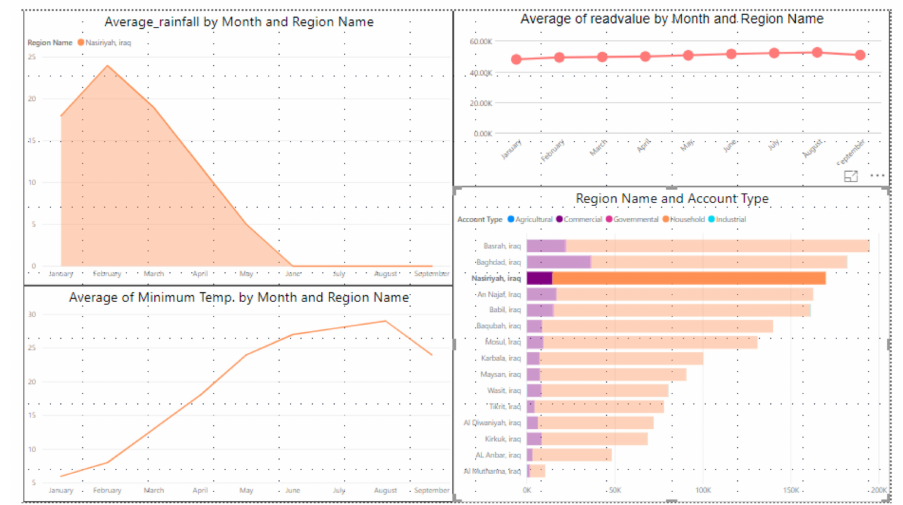
Figure 12. Dynamic Analysis of Nineveh (Mosul